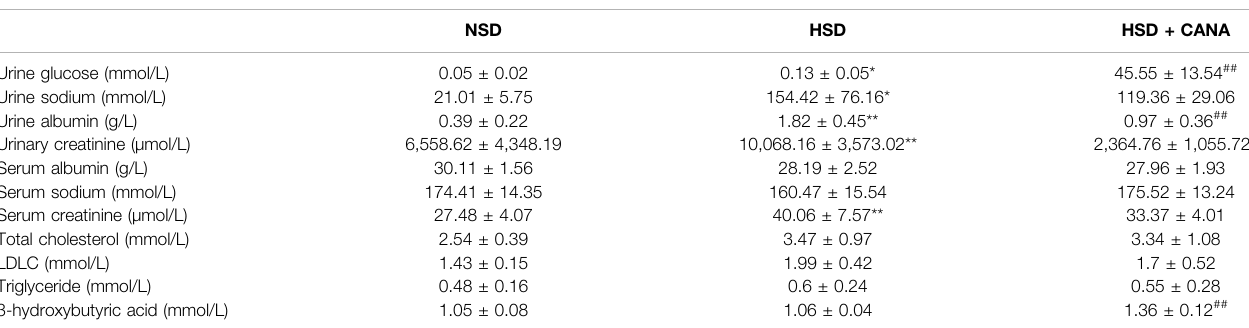
TABLE 3 | Effects of CANA on blood and urine measurements after treatment for 12